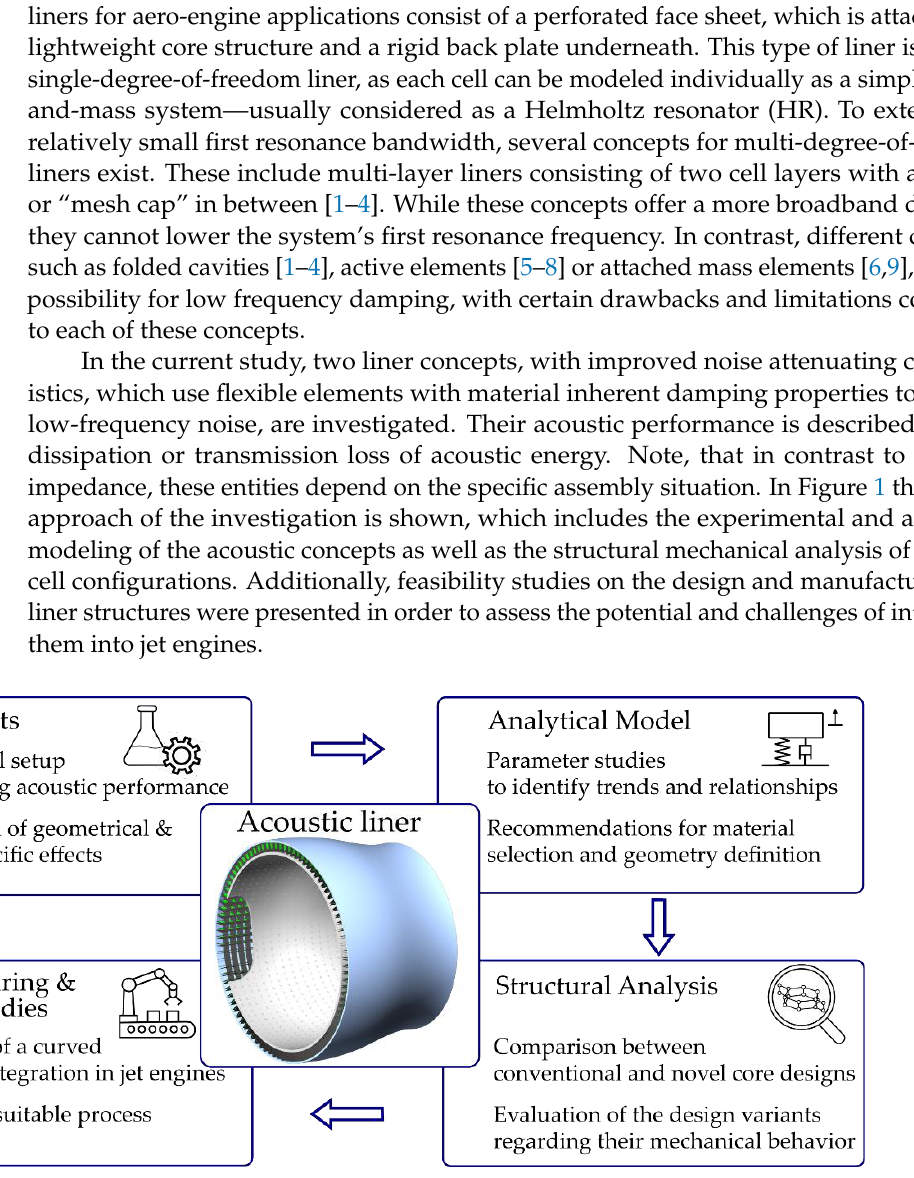
Figure 1. Holistic approach of the presented research to analyze novel acoustic liners concepts considering experimental, analytical modeling, structural mechanical and manufacturing aspects.